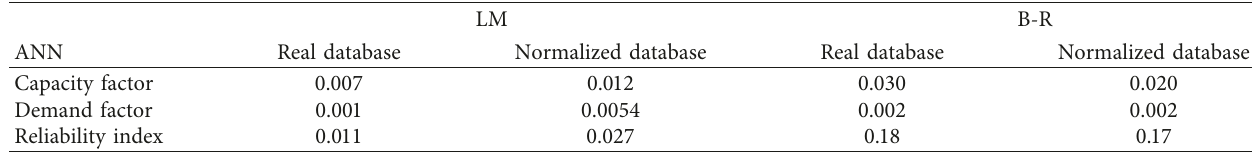
Table 6: Mean square error of ANN.